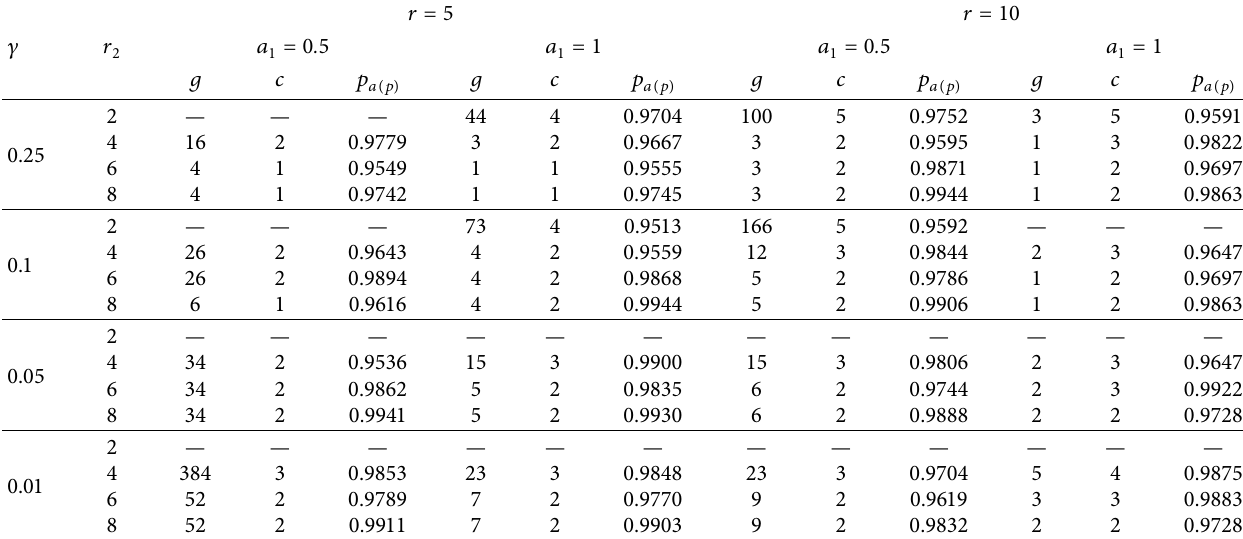
Table 2: GASP under the OPE model, showing minimum g and c when β � 1 and θ � 1 .